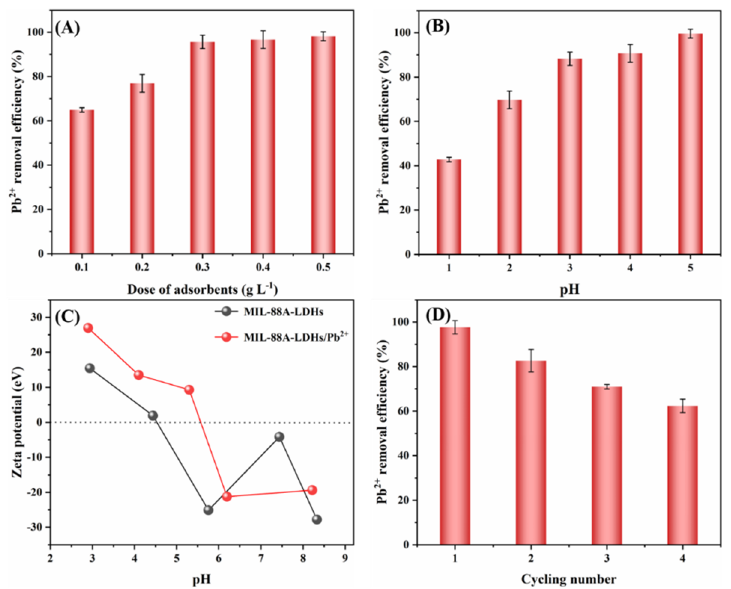
Figure 6. Effects of ( A ) adsorbent dosage and ( B ) solution initial pH. Experimental conditions: [Pb 2+ ] = 88 mg L − 1 , initial pH = 3.0, adsorbent dosage = 0.01 g, solution volume = 25 mL; t = 12 h. ( C ) zeta potential of MIL-88A-LDHs and MIL-88A-LDHs/Pb 2+ . ( D ) Cyclic performance of